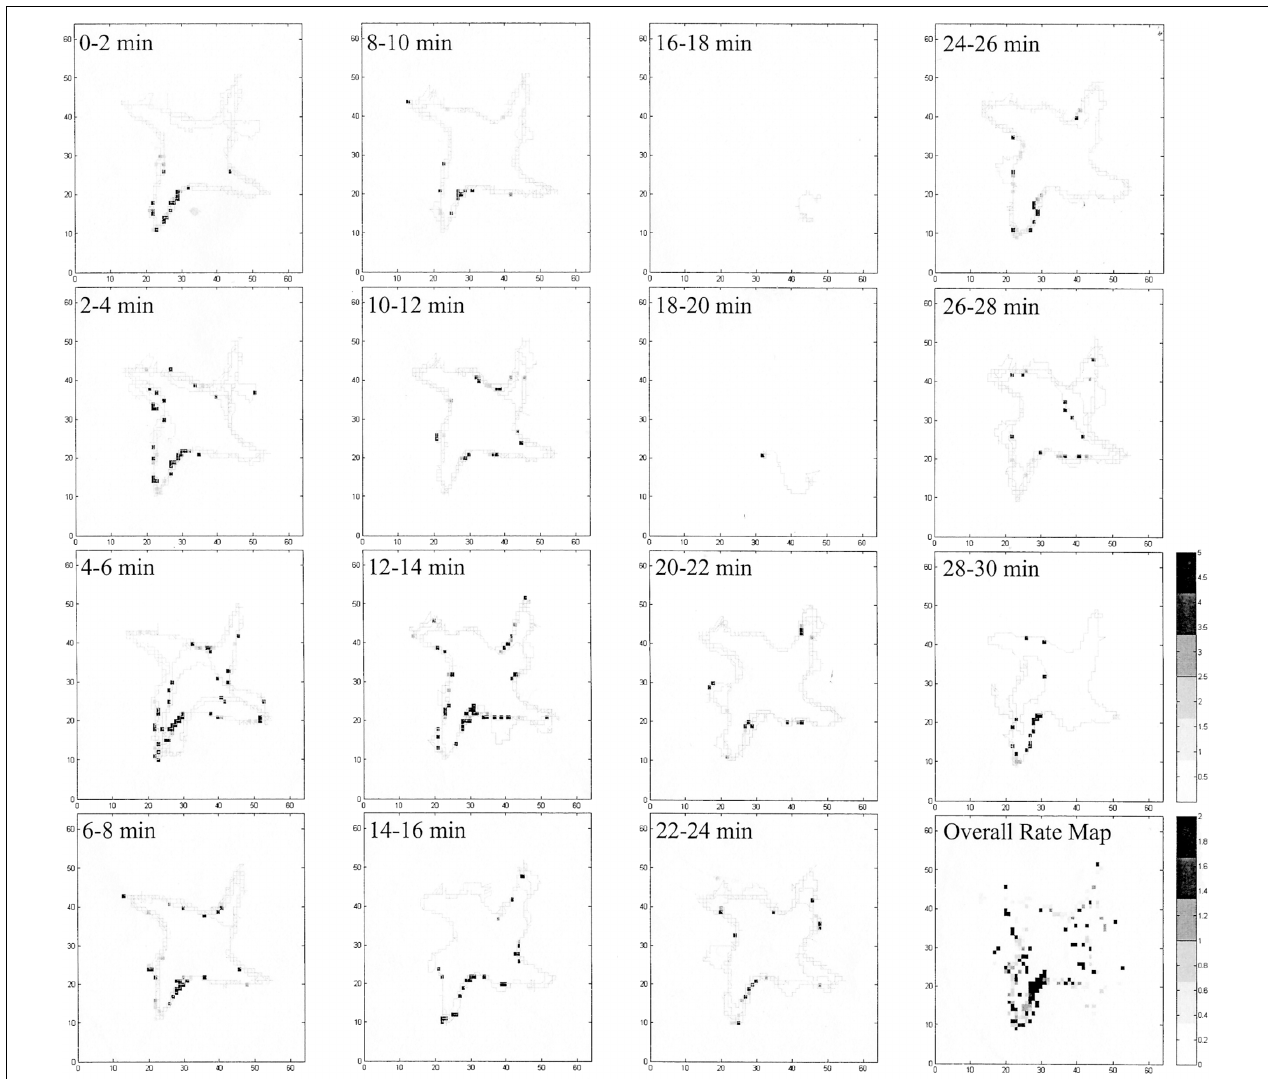
FIGURE 4 | Evidence of a pigeon place cell summarized in Figure 3B , broken into 2-min epochs. The cell consistently and reliably fired while in the entrance to the SW arm of the radial maze (black squares), even though the animal was visiting all four of the baited arms. The holding area portion of the experiment is not